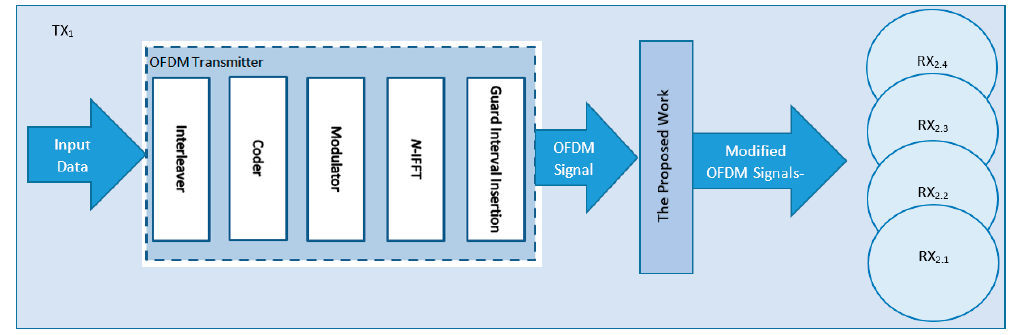
Figure 3. The physical layer modification for the V2V communications process.